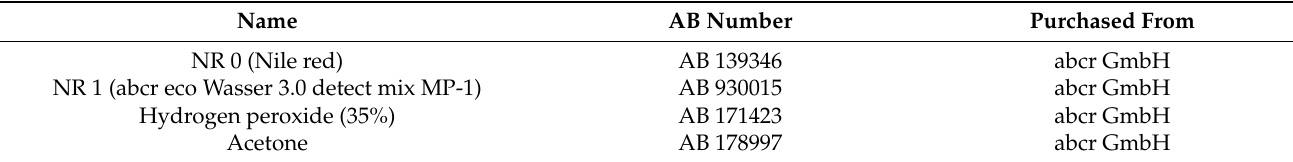
Table 5. List of chemicals used in the